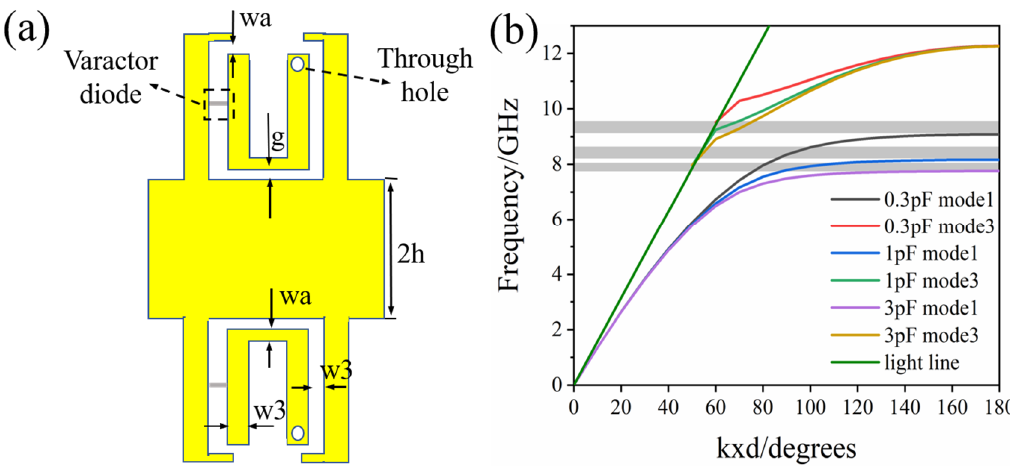
Figure 2. ( a ) The configuration of the dynamic modulation unit cell, where g = 0.2 mm, wa = 0.2 mm, w3 = 0.5 mm. ( b ) Dispersion diagrams of the proposed unit cell at different capacitances.